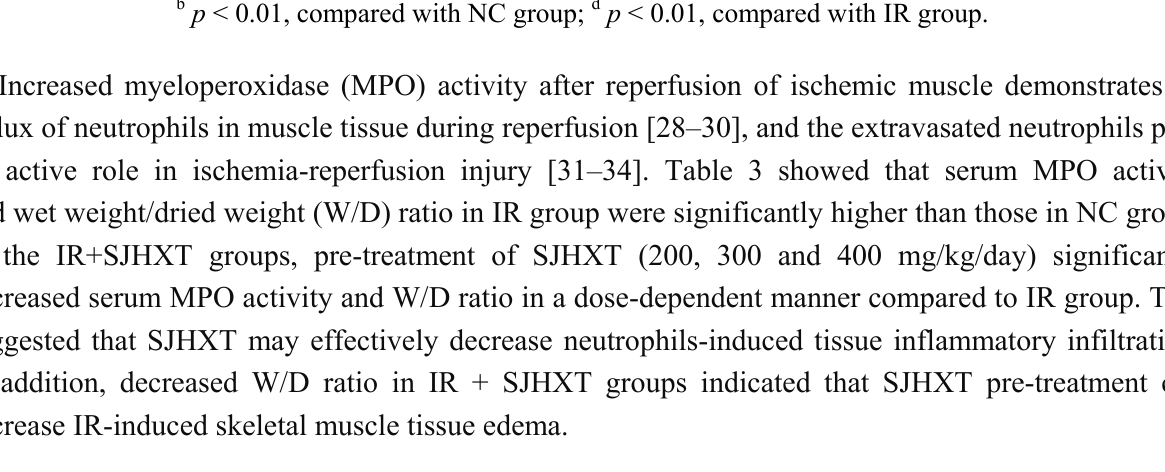
Table 3. Effect of SJHXT on serum MPO activity and W/D